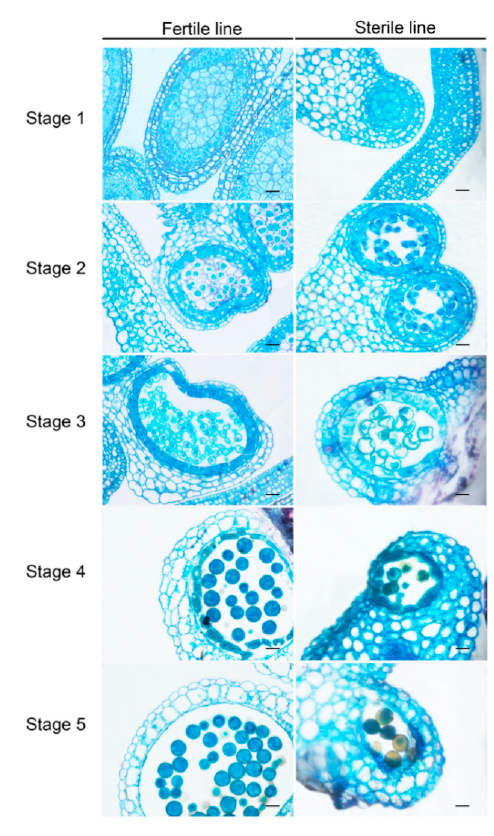
Figure 2. Pollen characteristics of Bcajh97-01B (fertile line) and Bcpol97-05A (sterile line) of Brassica campestris . ( A , B ) Pollen was dyed with Alexander’s stain. ( C – F ) Pollen was dyed with 4’, 6-diamidino-2-phenylindole.